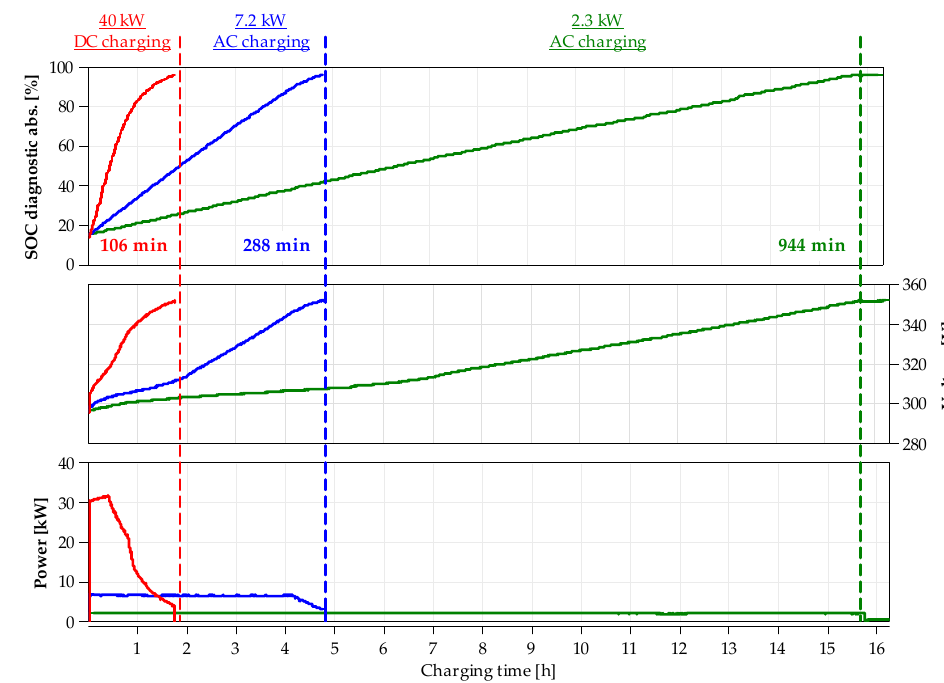
Figure 23. Charging times for SKODA CITIGOe IV, depending on selected charging power. Table 1. Time necessary to charge battery for 100 km range in urban area [54]